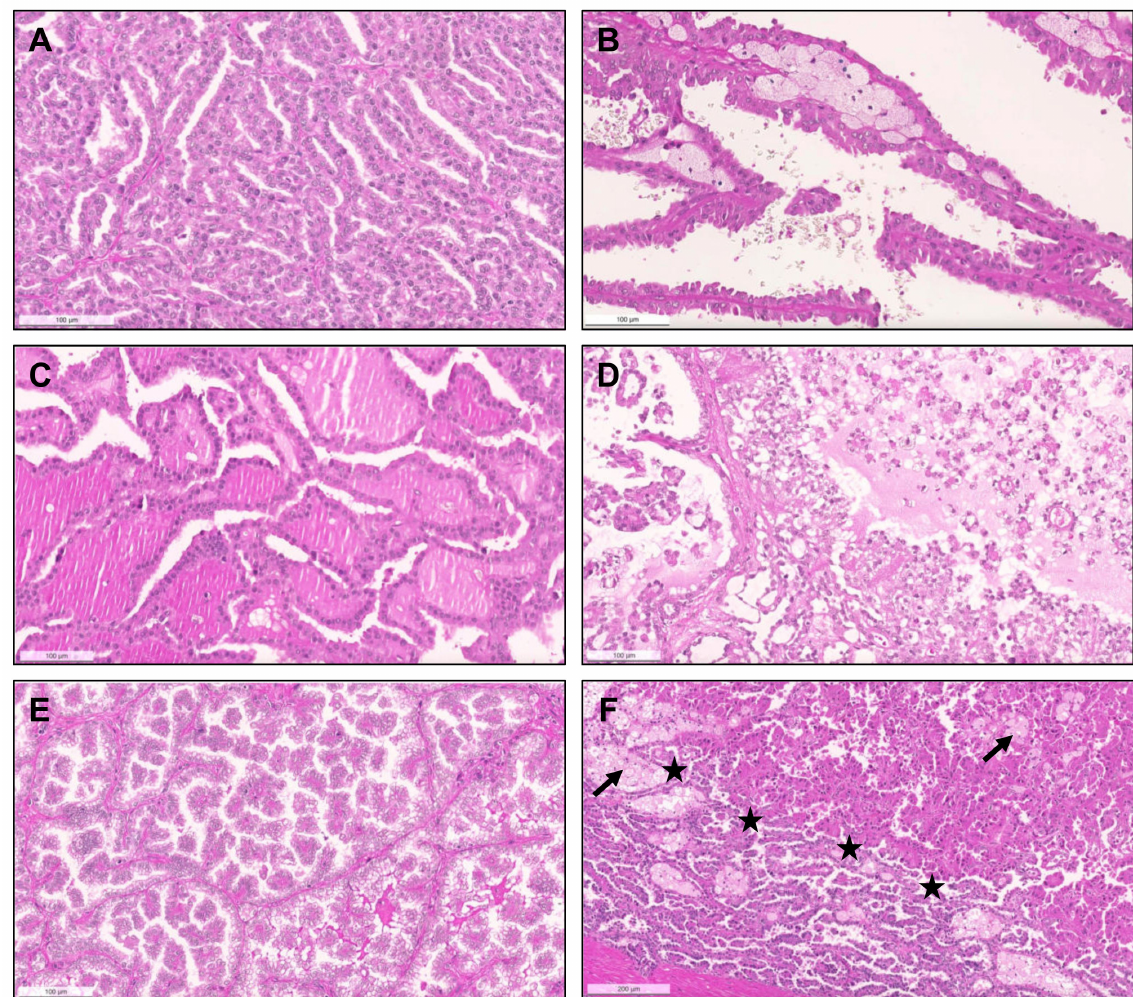
Figure 1. Heterogeneous histological patterns within pRCC. ( A – E ): ( A ) a case of a pRCC difficult to ascertain “a type”, due to the presence of multiple architectural patterns and cytological features within the same tumor, including packed elongated thin papillae filled by cells with small nuclei of lower WHO/ISUP grade; ( B ) elongated papillae lined by larger cells with eosinophilic cytoplasm, higher nuclei grade, pseudostratification of nuclei and hobnailing/apical snouts; ( C ) tubular/tubulocystic areas with small eosinophilic cells, filled with colloid-like material; ( D – E ) micropapillary images, with the presence of clear cells admixed with eosinophilic cells, dispersed within the stroma or within tubulopapillary structures; ( F ) a case of a pRCC showing an abrupt transition (stars) from a type 1 (classic) area, with thin papillae covered by small cells with pale cytoplasm and lower nuclear grade (bottom), to a type 2 area, with more dense papillae, covered by larger eosinophilic cells, with larger nuclei and nucleoli, and pseudostratification (top). Notice the typical xanthomatous macrophages common in pRCC